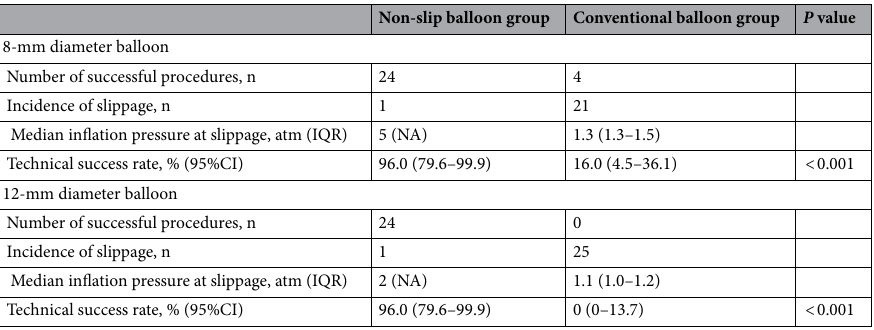
Table 2. Outcomes of the ex vivo experiment. IQR , interquartile range; CI, confidence interval.